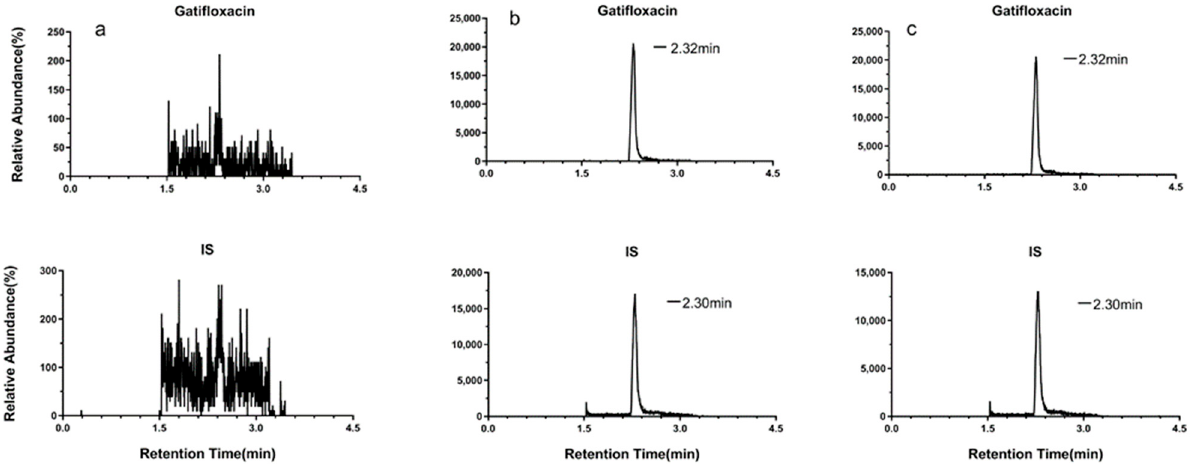
Figure 1. Representative multiple reaction monitoring (MRM) chromatograms of ( a ) a blank corneal homogenate; ( b ) a corneal homogenate spiked with 0.4 µ g/mL gatifloxacin and the IS; and ( c ) a corneal sample from the rabbit in group A1.